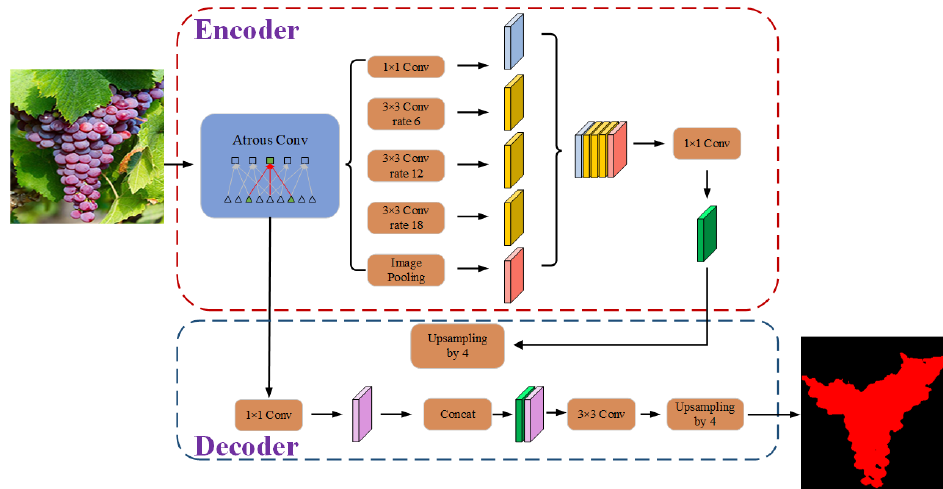
Figure 1. The Encoder module and Decoder module of DeepLabv3+.